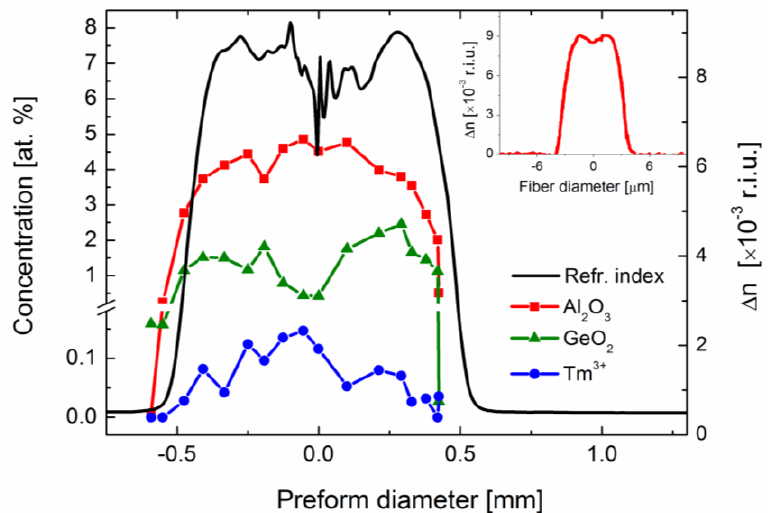
Figure 4. Refractive index profile and dopant concentration profile of prepared optical fiber preform SD (the inset plot contains the refractive index profile of the optical fiber).